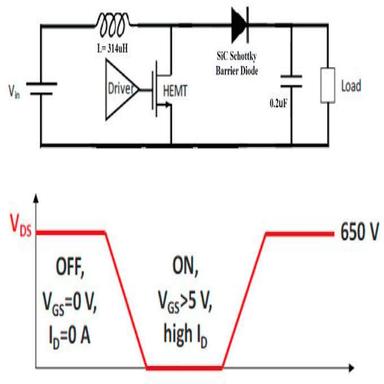
Shows a representation of switching mode power converter, which consist of the inductor (L) of 315 μH, the 0.2 μF of capacitor, the SiC barrier diode, the Voltage input terminal and the QB-MIS-HEMT.